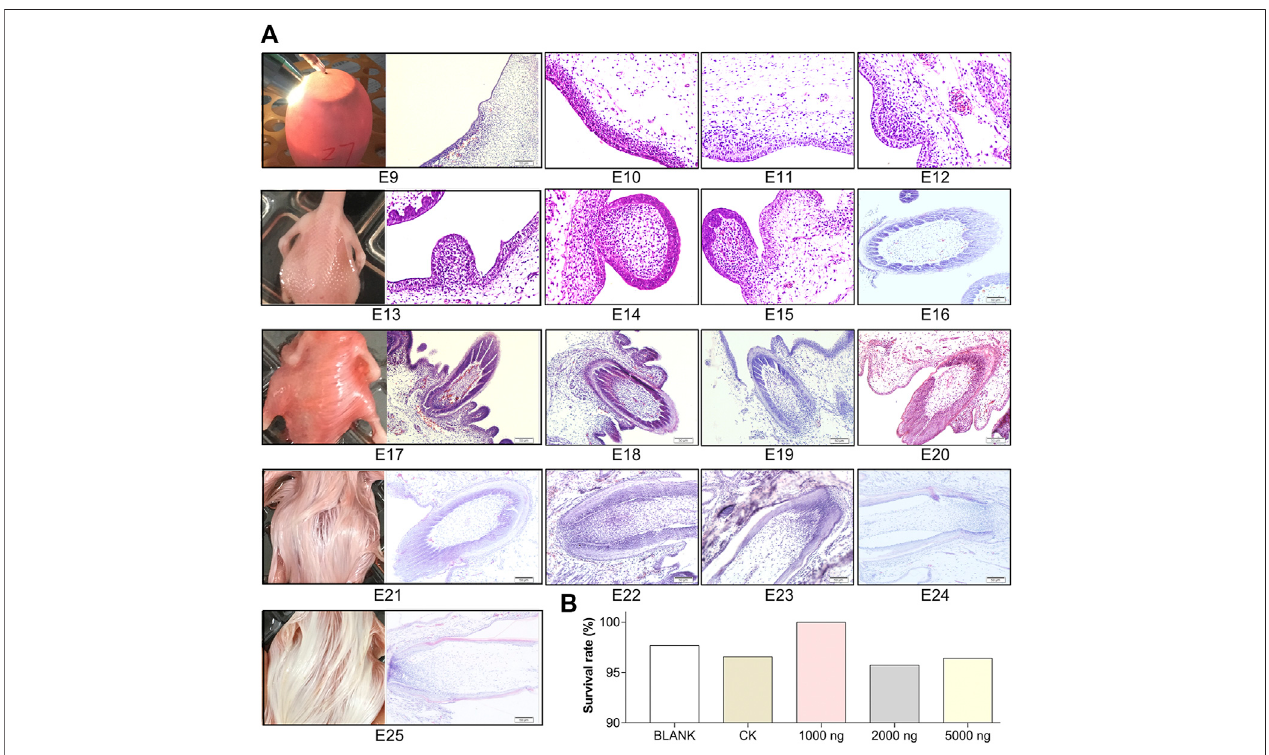
FIGURE1| Featherfolliclemorphogenesisdeterminesthetimenodesforgooseembryosinovoinjectionandsampling. (A) Representativeimagesoffeatherfollicle morphology during E9 to E25 as indicated by H&E, operation of in ovo injection at E9, and dorsal feather phenotypes at E13, E17, E21, and E25. Bar = 50 μ m. (B) Survival rate of each group (data from 50 fertilized eggs of each